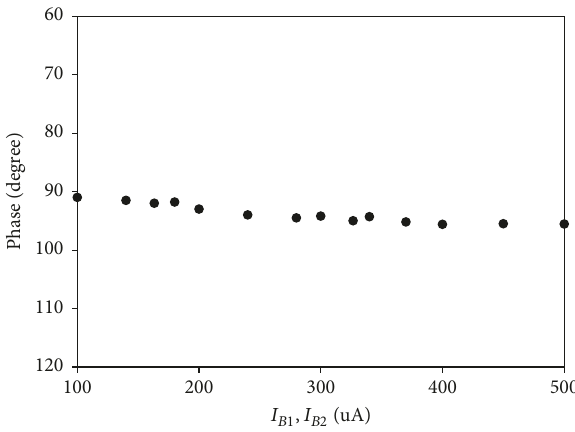
Figure 11: The measured phase difference of 𝑉 𝑂1 and 𝑉 𝑂2